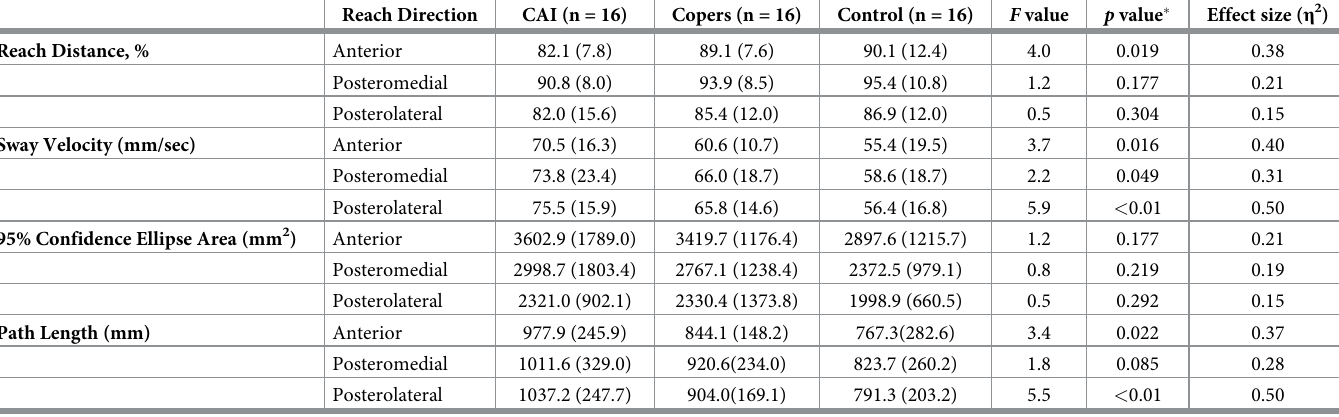
Table 2. Mean (SD) of postural control by reach direction among study